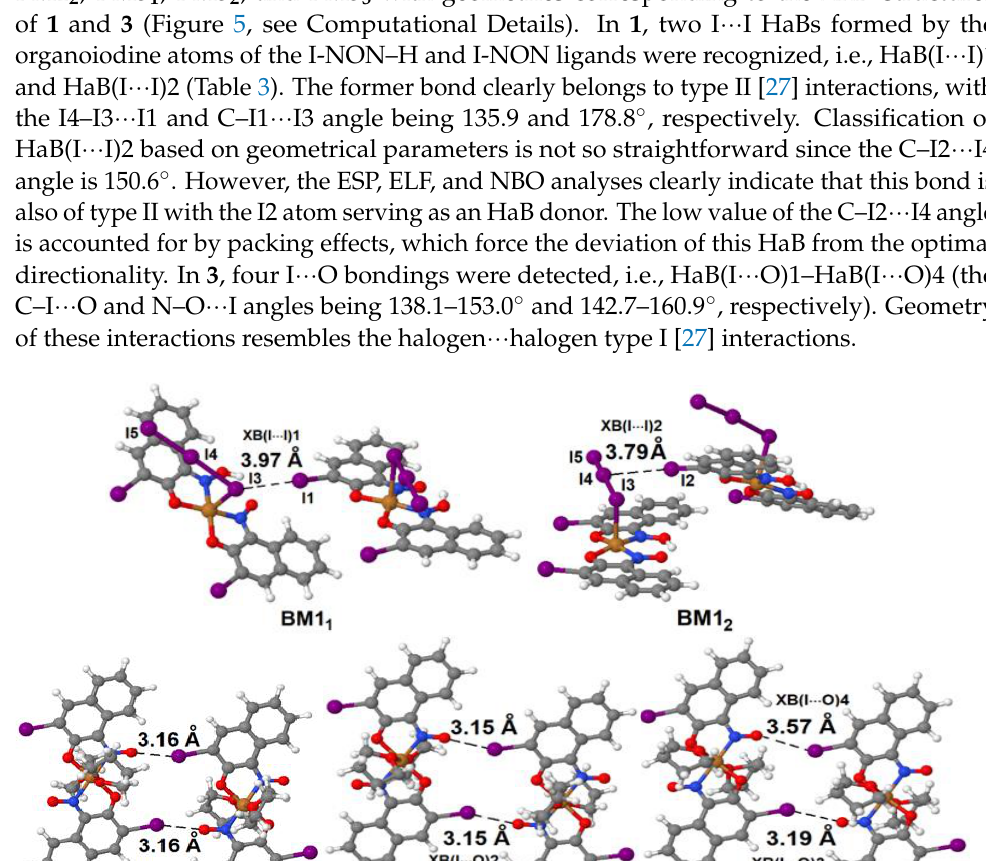
Table 4. Halogen bond lengths, d (in Å), calculated electron density, ρ b , its Laplacian,  2 ρ b , potential and kinetic energy densities, V b and G b , second eigenvalue of the hessian matrix, λ 2,b , at BCPs (in a.u.) and interaction energies, E int (in kcal/mol).